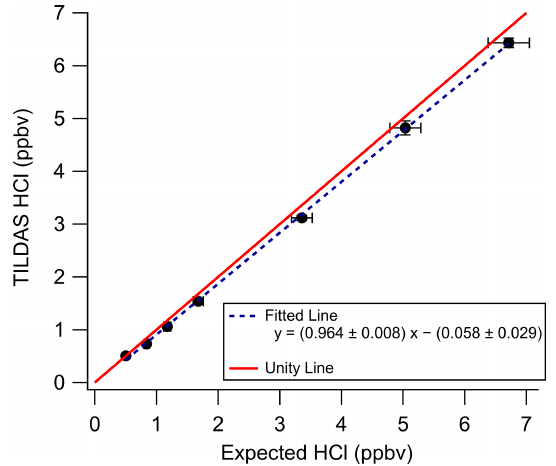
Figure 4. In-lab validation of HCl-TILDAS by a commercial HCl standard. Principal axis error bars represent the 5% uncertainty as- sociated with the HCl standard (as reported by the manufacturer), while the vertical axis error bars represent 1 standard deviation of HCl-TILDAS observations for each validation point. Note the re- gression line is used here only for the purposes of technique valida- tion and is not used for calibrating